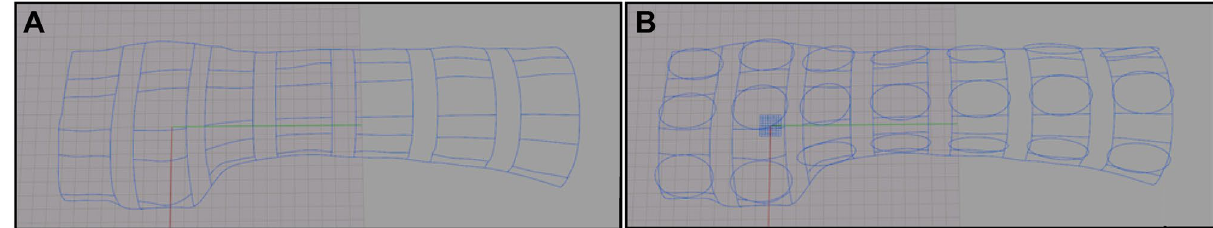
Fig. 8 Holes pattern: A Starting squared grid; B Circular holes Fig. 9 Upper shell fully assem- bled: A —label slot; B —fas- tener; C —Pin-hole